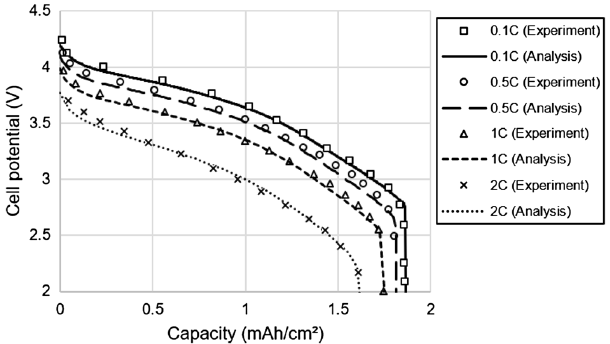
Figure 2. Comparison of discharge curves of the LIB cell between experiment 8 and analysis.